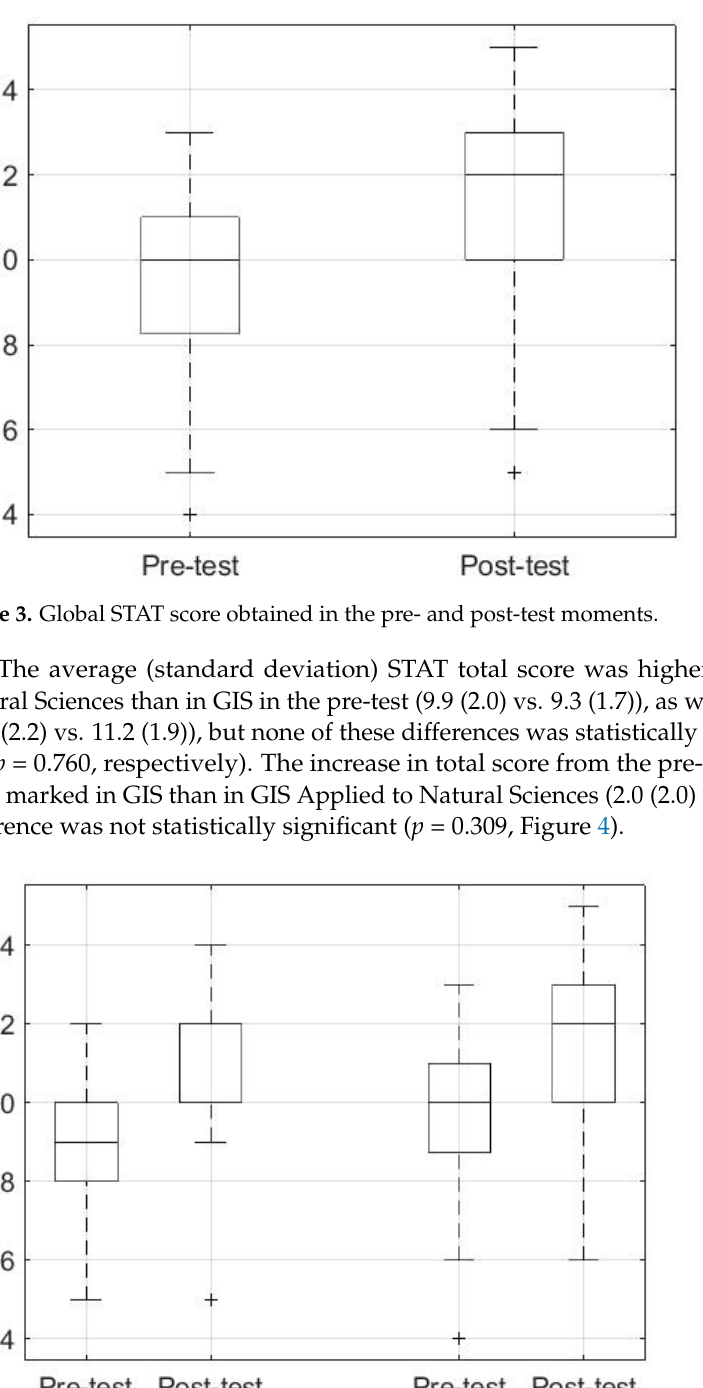
Although the differences in student performance between the five courses were not statistically significant for the pre-test ( p = 0.068), some differences should be highlighted, namely the lower scores for students of “Landscape Architecture” and master in “Environ- mental Sciences and Technologies” (Figure 5). On the other hand, the student performance between the courses was more similar based on the post-test ( p = 0.556). From Figure 5, an outlier in the “Landscape Architecture” course can also be observed, where a